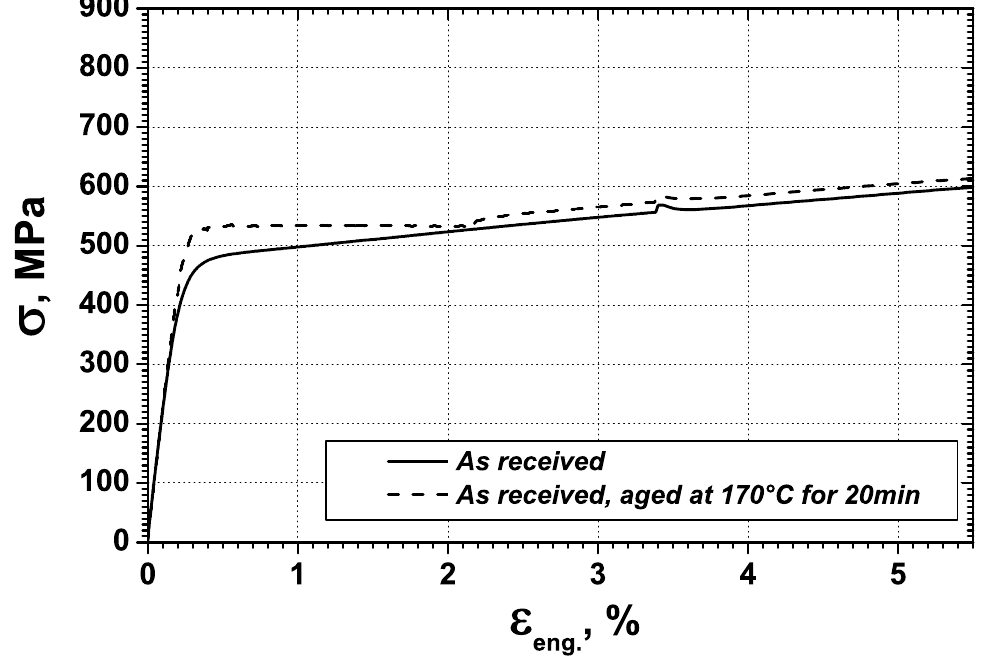
Figure 18. Stress–Strain curves for the TRIP5 steel without and with aging at 170 ◦ C for 20